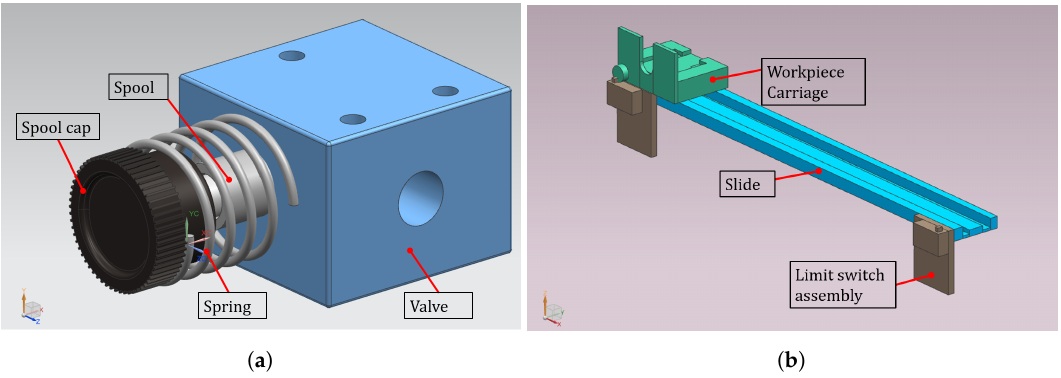
Figure 6. ( a ) work piece—valve assembly; ( b ) slide mechanism.